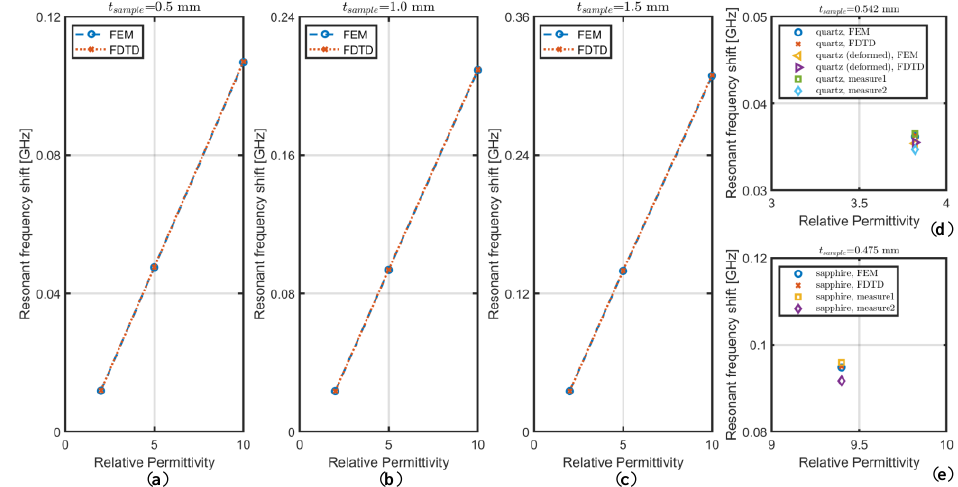
Figure 3. Resonant frequency shifts with respect to the case without inserting a sample for FEM and FDTD simulations for the samples ( a ) with 0.5 mm thickness, ( b ) with 1.0 mm thickness, and ( c ) with 1.5 mm thickness. ( d ) Resonant frequency shifts for the quartz sample; ( e ): resonant frequency shifts for the sapphire sample.